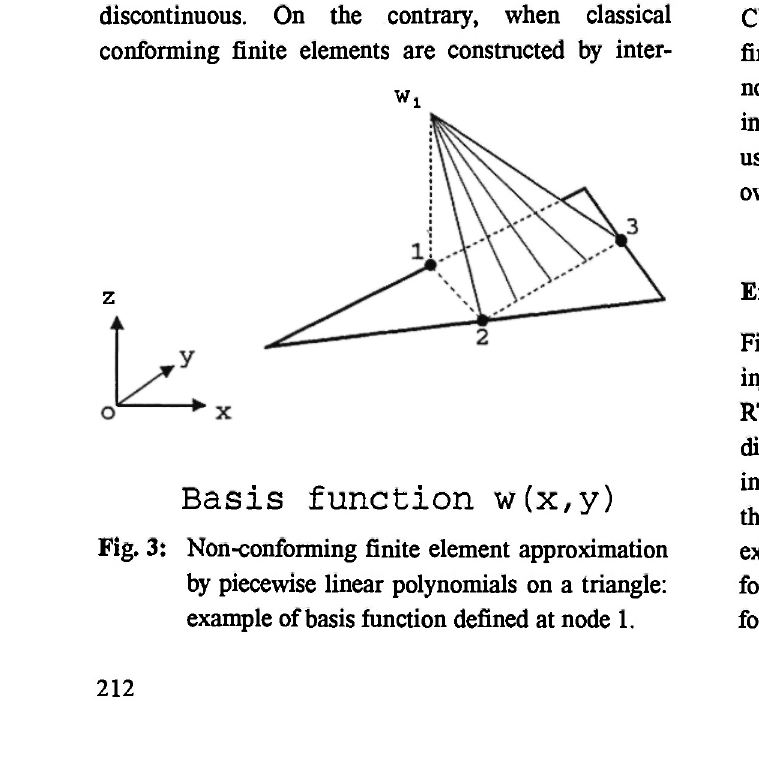
Fig. 3: Non-conforming finite element approximation by piecewise linear polynomials on a triangle: example of basis function defined at node